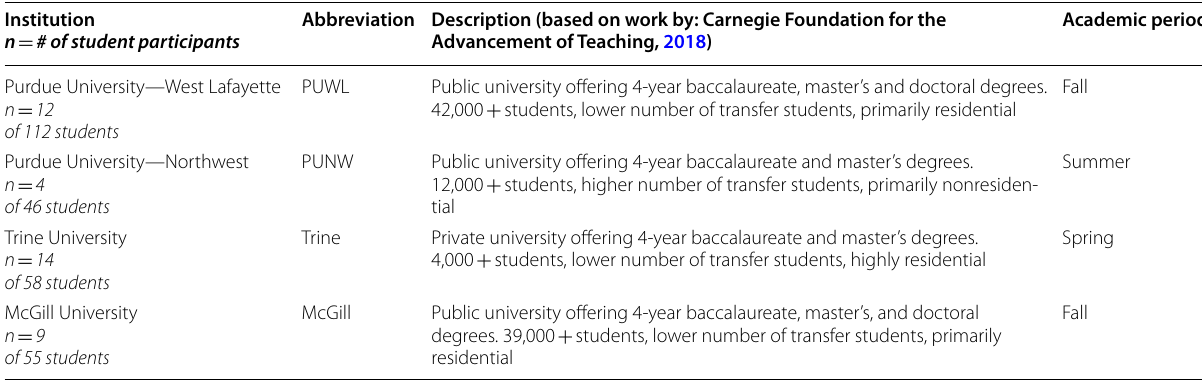
Table 2 Summary of participating